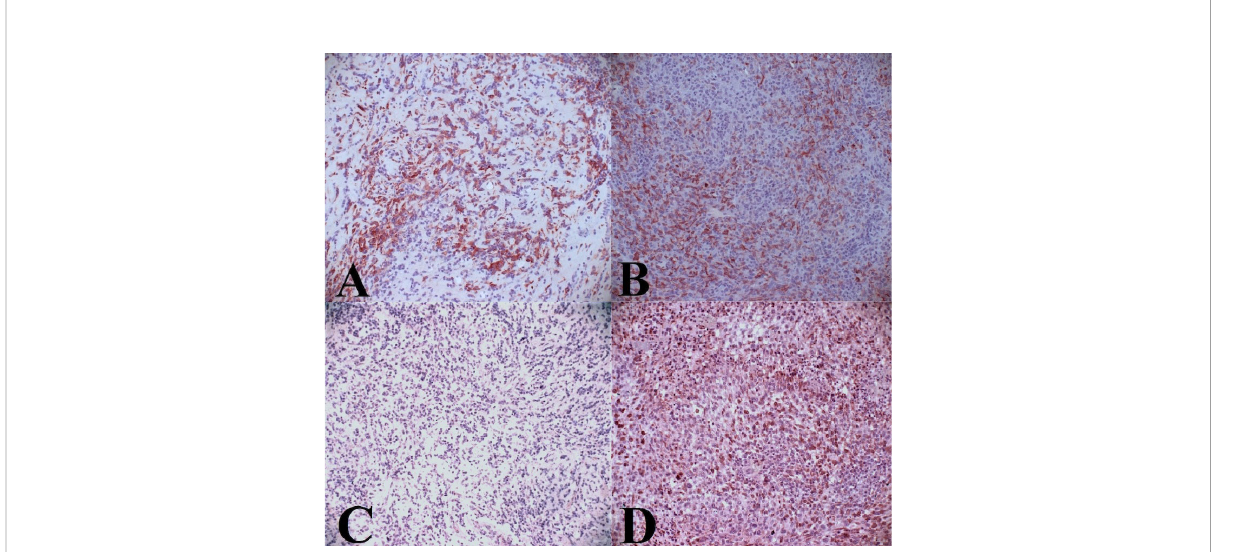
FIGURE 6 Representative of CD204 and CD206 marker. (A) Intratumoral in fi ltration of CD204. Moderate positive labeling in group 1, (B) intratumoral in fi ltration of CD204. Moderate positive labeling in control group, (C) Absence of intratumoral in fi ltration of CD206 in group 1, (D) Intratumoral in fi ltration of CD206. moderate to severe positive labeling in group